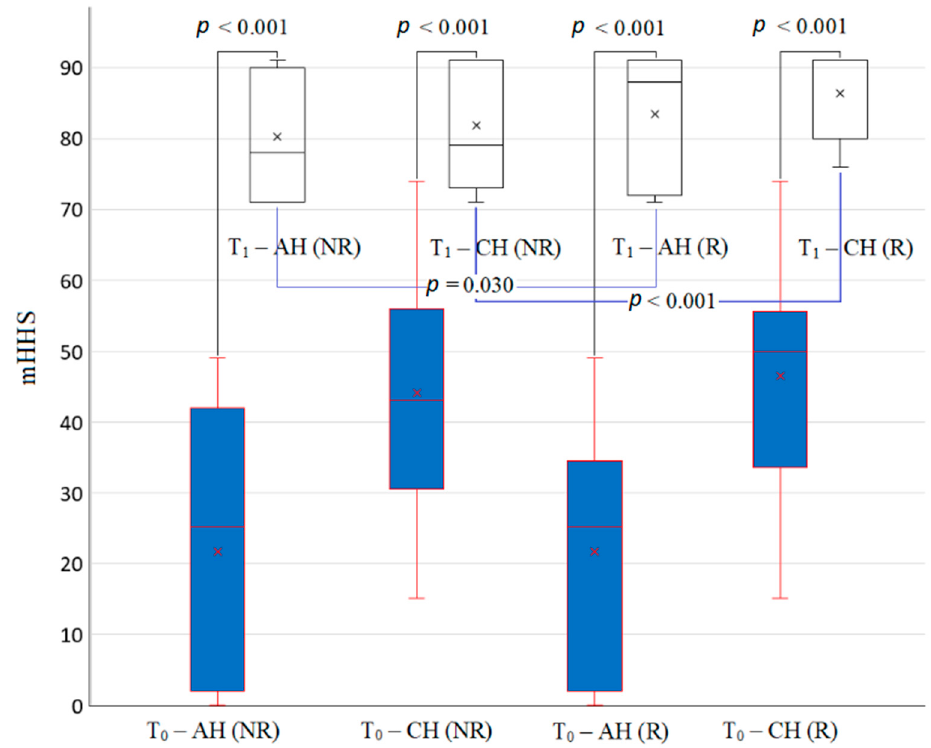
Figure 1. The evolution of the modified mHHS during the study. Legend: mHHS—modified Harris hip score; group A—group with recovery, group B—group without recovery, AH—arthroplasty hip, CH—contra lateral hip, p values—statistical significance ( t -test), T 0 —before surgery, T 1 —90 days after the surgery.